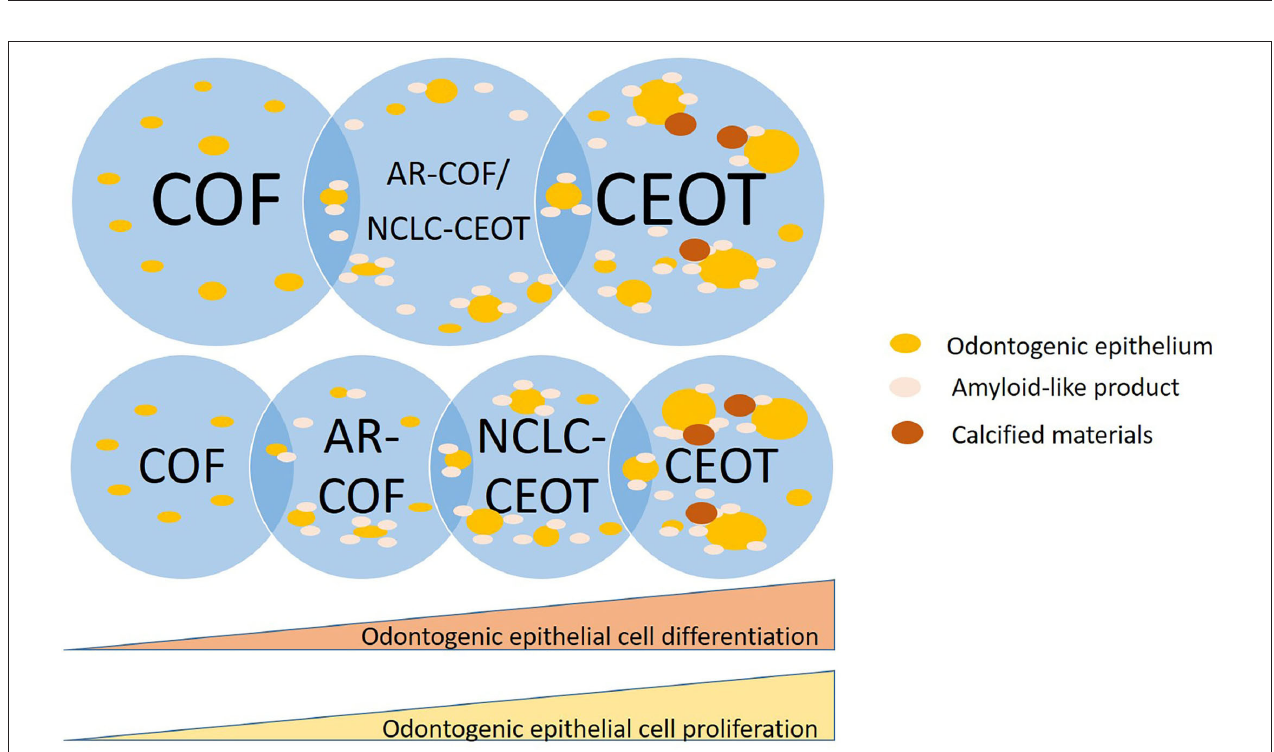
FIGURE 6 | Schematic diagram of NCLC-CEOT/AR-COF is a unique disease entity or in a spectrum of COF/CEOT.